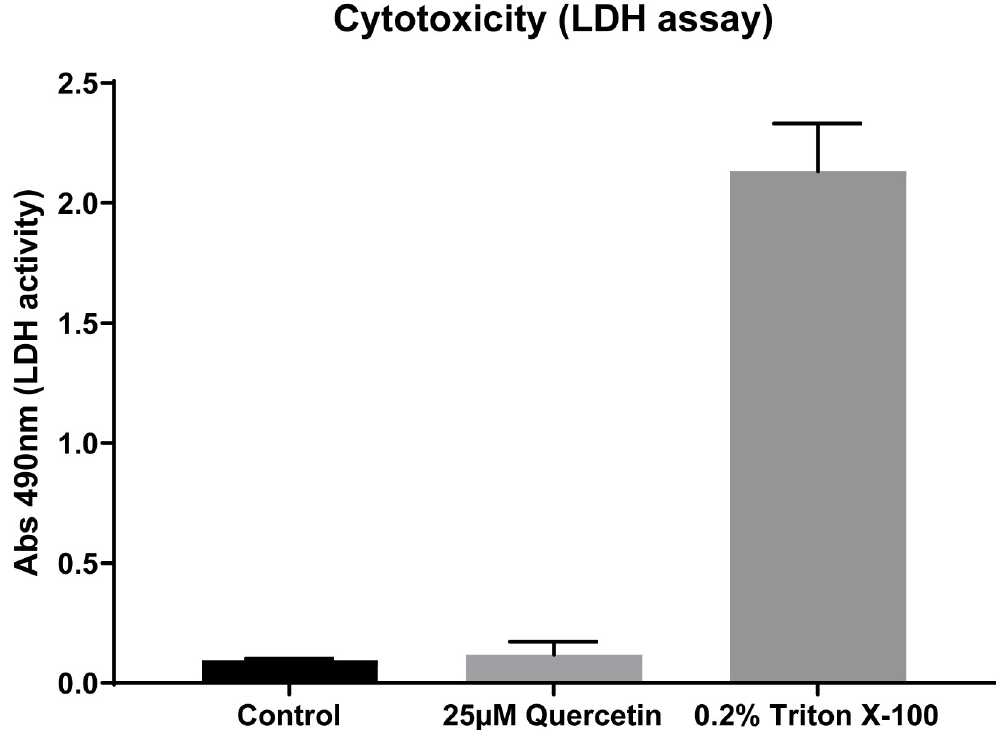
Fig 6. Quercetin cytotoxicity: Human bronchial epithelial cells in ALI state untreated (Control), treated with 25 μ M quercetin and positive control (Triton X-100, 0.2%), N = 9/group one-way ANOVA.